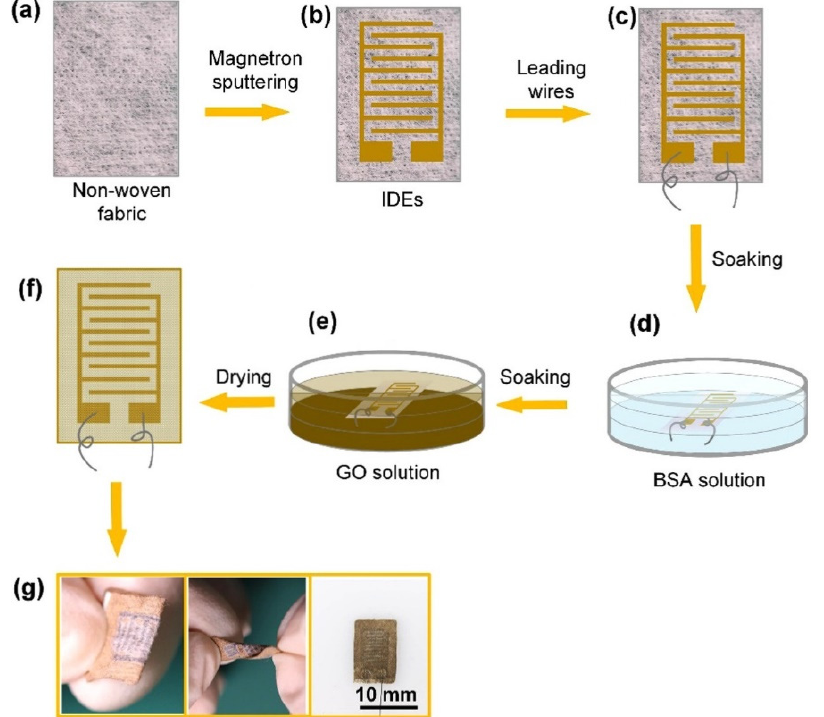
Figure 4. Representation of the fabrication steps of the GO/non-woven fabric-based sensors for respiratory applications. ( a ) The non-woven fabric taken as the processed material was used as substrates to form ( b ) interdigitated electrodes (IDEs) and ( c ) attach connecting wires. ( d ) The samples were then treated with ( d ) bovine serum albumin (BSA) solution and ( e ) graphene oxide (GO) solution. ( f ) The samples were then dried and used for experimental purposes. ( g ) The mechanical flexibility and final dimension of the sensors [134].